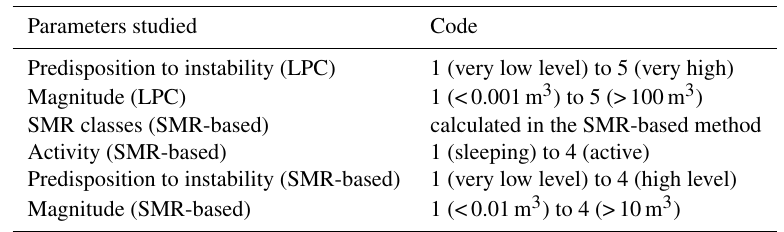
Table 14. Code of the parameters used in the LPC and SMR-based